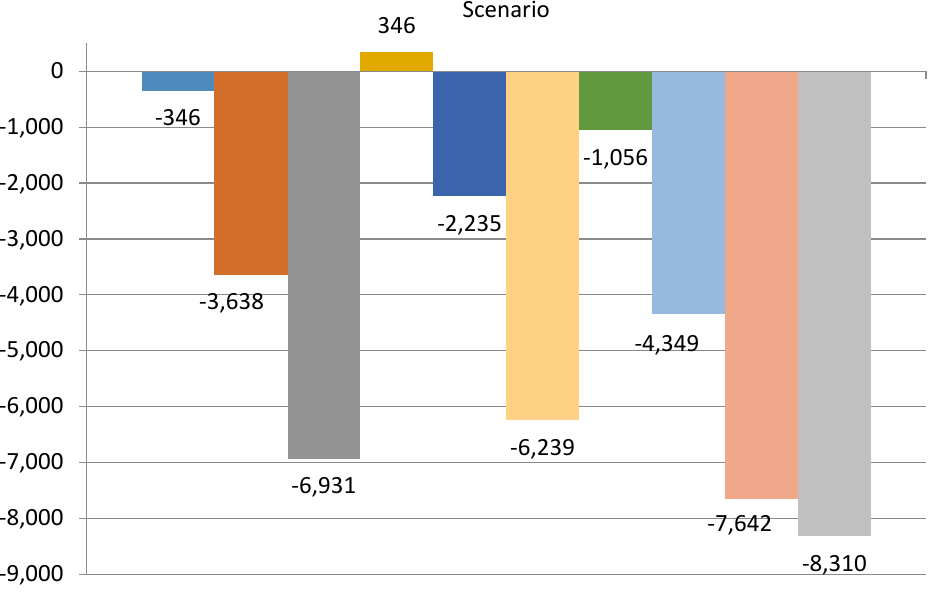
Figure 6. NPV for each scenario if the forecasting period equals seven years (tPLN).